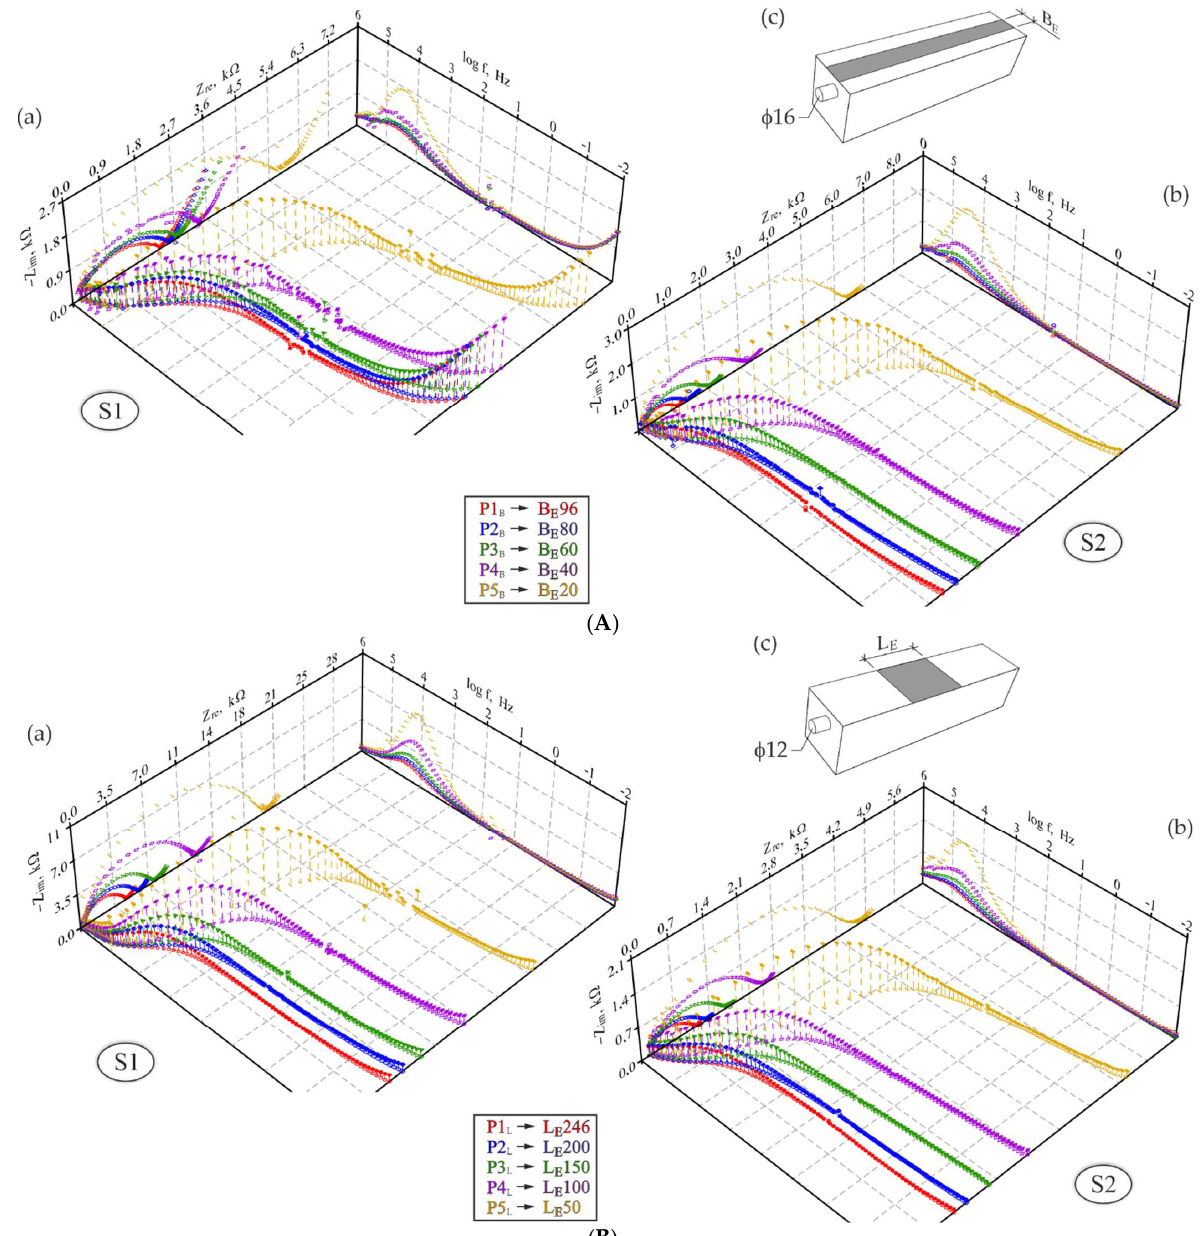
Figure 4. ( A ). Spatial diagrams (as a function of real impedance Z re , imaginary impedance Z im and measurement frequencies f ) representing distribution of impedance spectra obtained for: (a) and (b) rebars ϕ 12 mm at a changing width B E of the counter electrode, in test elements of series S1 and S2 , respectively, (c) schematic drawing of the test element with a changing width B E . ( B ). Spatial diagrams (as a function of real impedance Z re , imaginary impedance Z im and measurement frequencies f ) representing distribution of impedance spectra obtained for: (a) and (b) rebars ϕ 16 mm at a changing length L E of the counter electrode in test elements of series S1 and S2 , respectively; (c) schematic drawing of the test element with a changing length L E